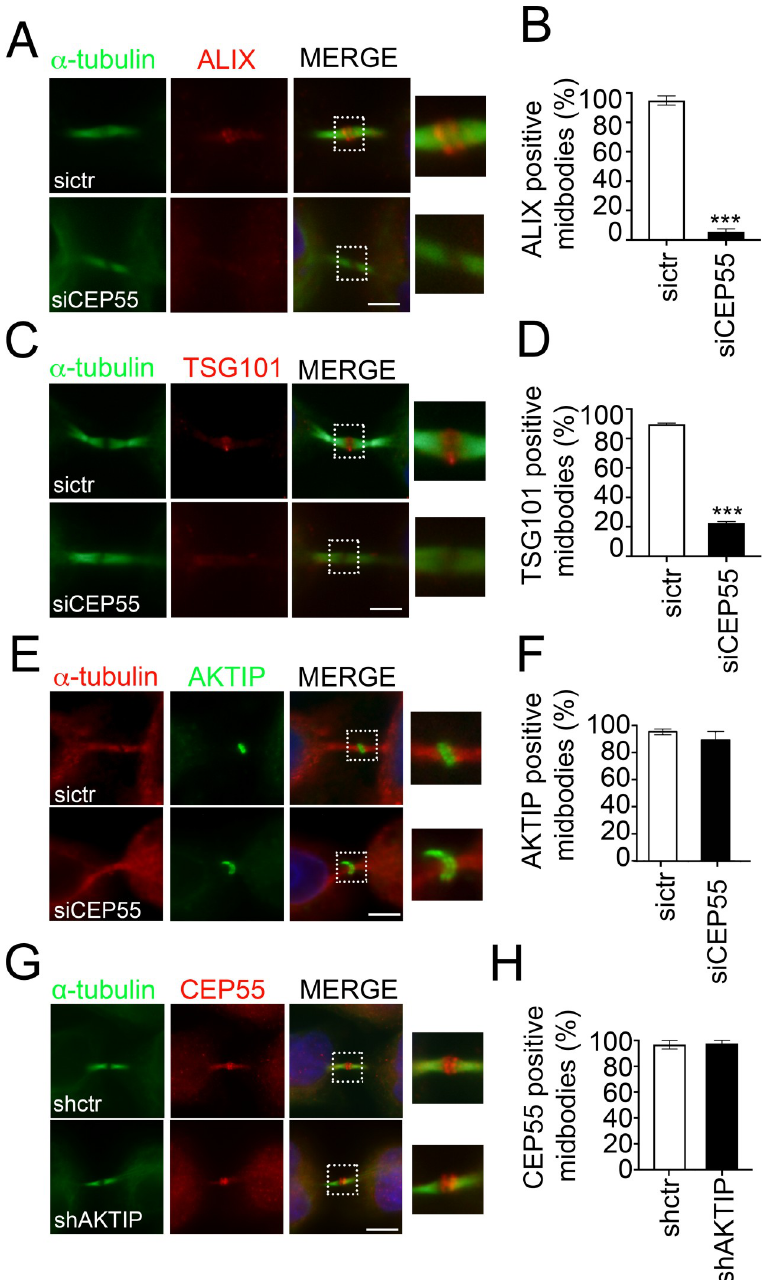
Fig 5. AKTIP recruitment to the midbody is CEP55 independent. (A-B) Representative images and quantification of sictr and siCEP55 HeLa cells stained for ALIX (red) and α -tubulin (green). (C-D) Representative images and quantification of sictr and siCEP55 HeLa cells stained for TSG101 (red) and α -tubulin (green). (E-F) Representative images and relative quantification of sictr and siCEP55 HeLa cells stained for AKTIP (green) and α -tubulin (red). (G-H) Representative images and relative quantification of shctr and shAKTIP HeLa cells stained for CEP55 (red) and α -tubulin (green). For results in (B, D, F and H) at least 100 midbodies per condition were counted. Scale bar, 5 μ m.